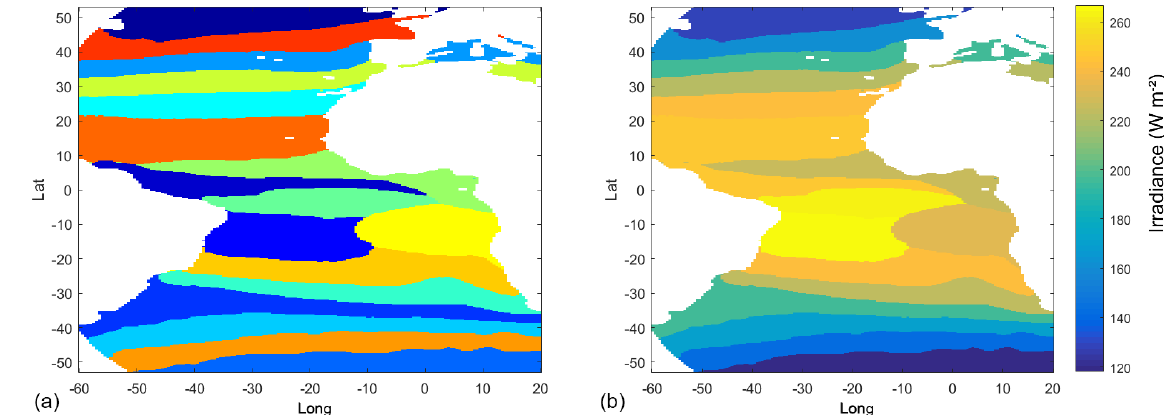
Figure 2. Map of the 17 resulting classes of DSIS (a) . Map of the same classes but whose colour indicates the yearly mean of the DSIS (b) .